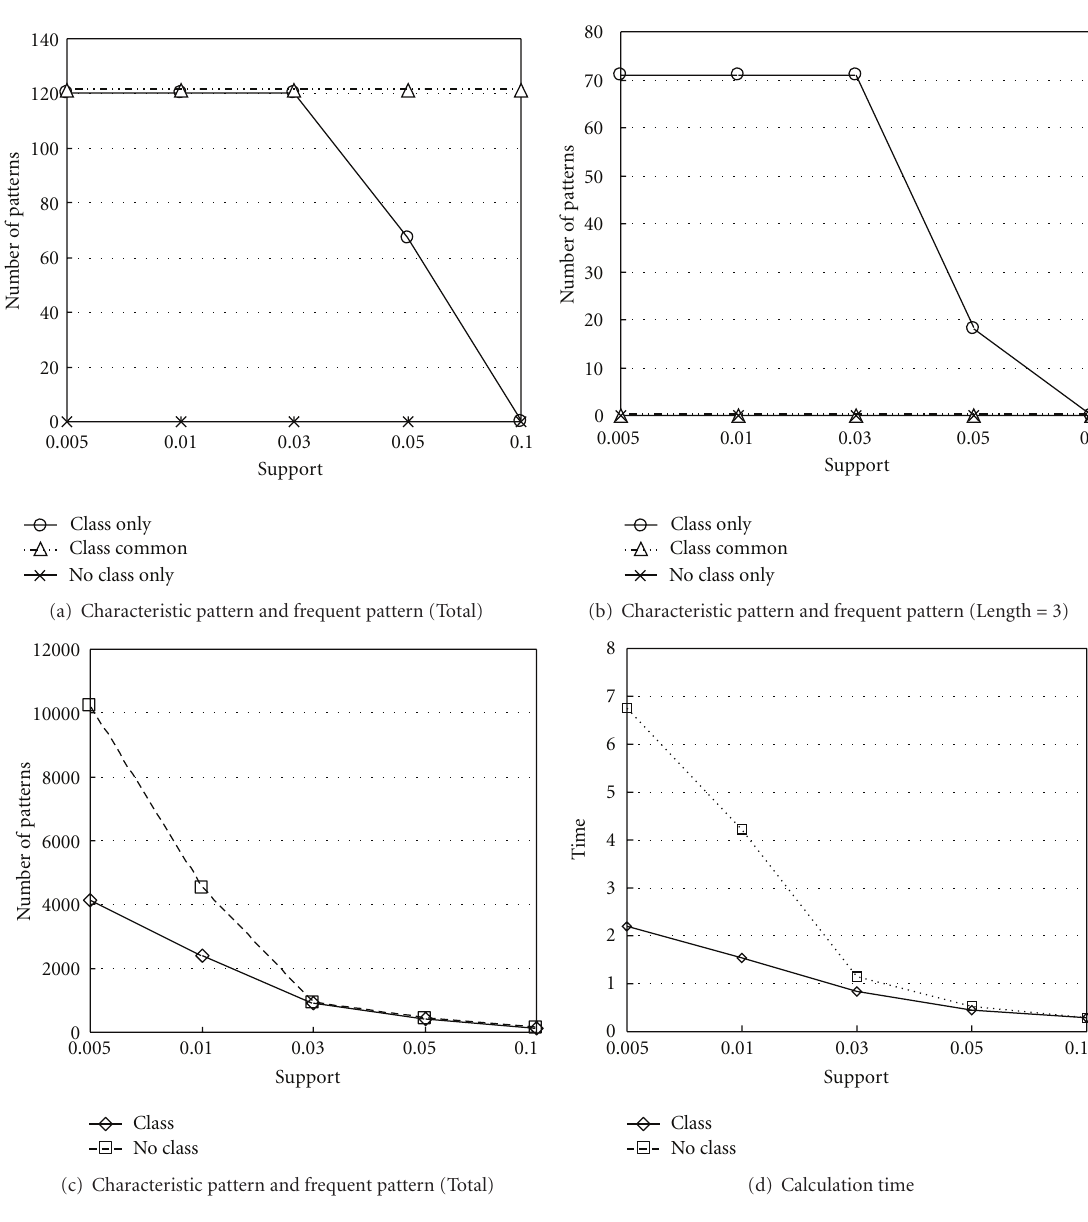
Figure 5: Experimental result in the case of the data set